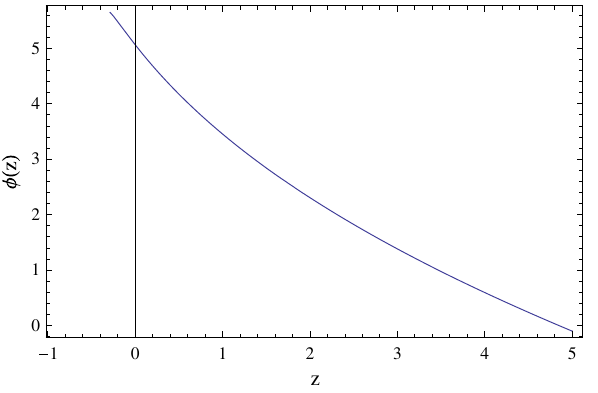
Fig. 15 Variation of f (φ) with the variation of φ for the CPL param-